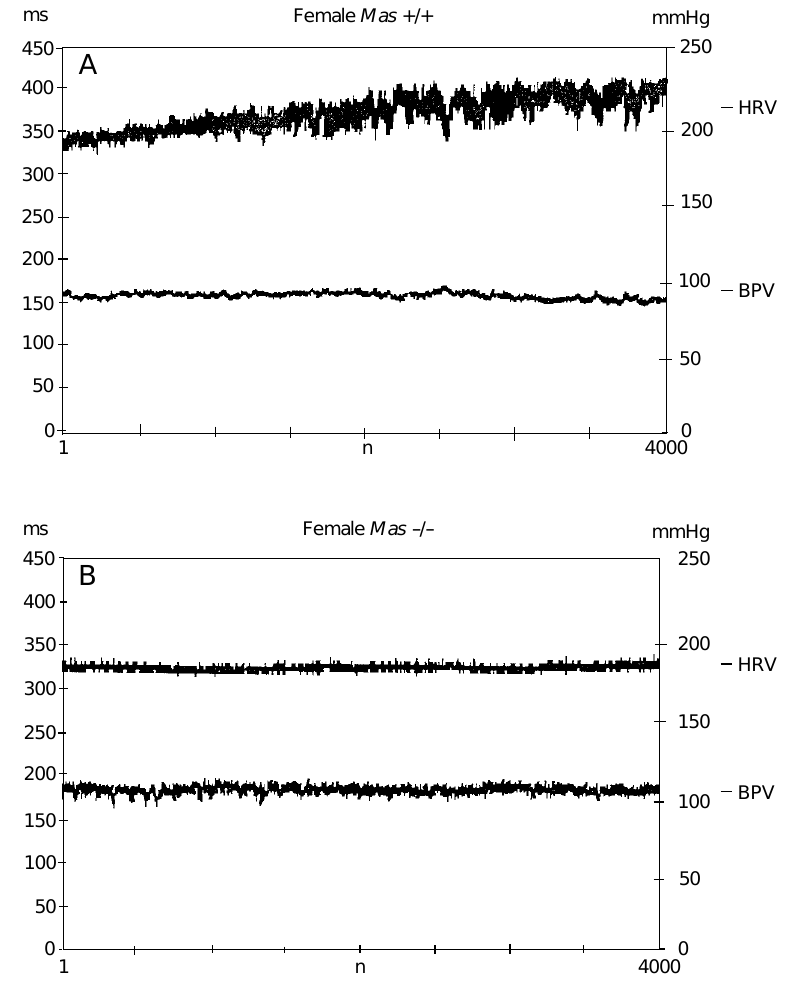
Figure 3 - Continuous measurement of heart rate (HR) in beats/min and systolic blood pressure (BP) in mmHg in a female wild-type (A) and a female Mas -deficient animal (B) for 16 s. HRV and BPV, Heart rate and blood pressure variabilities,